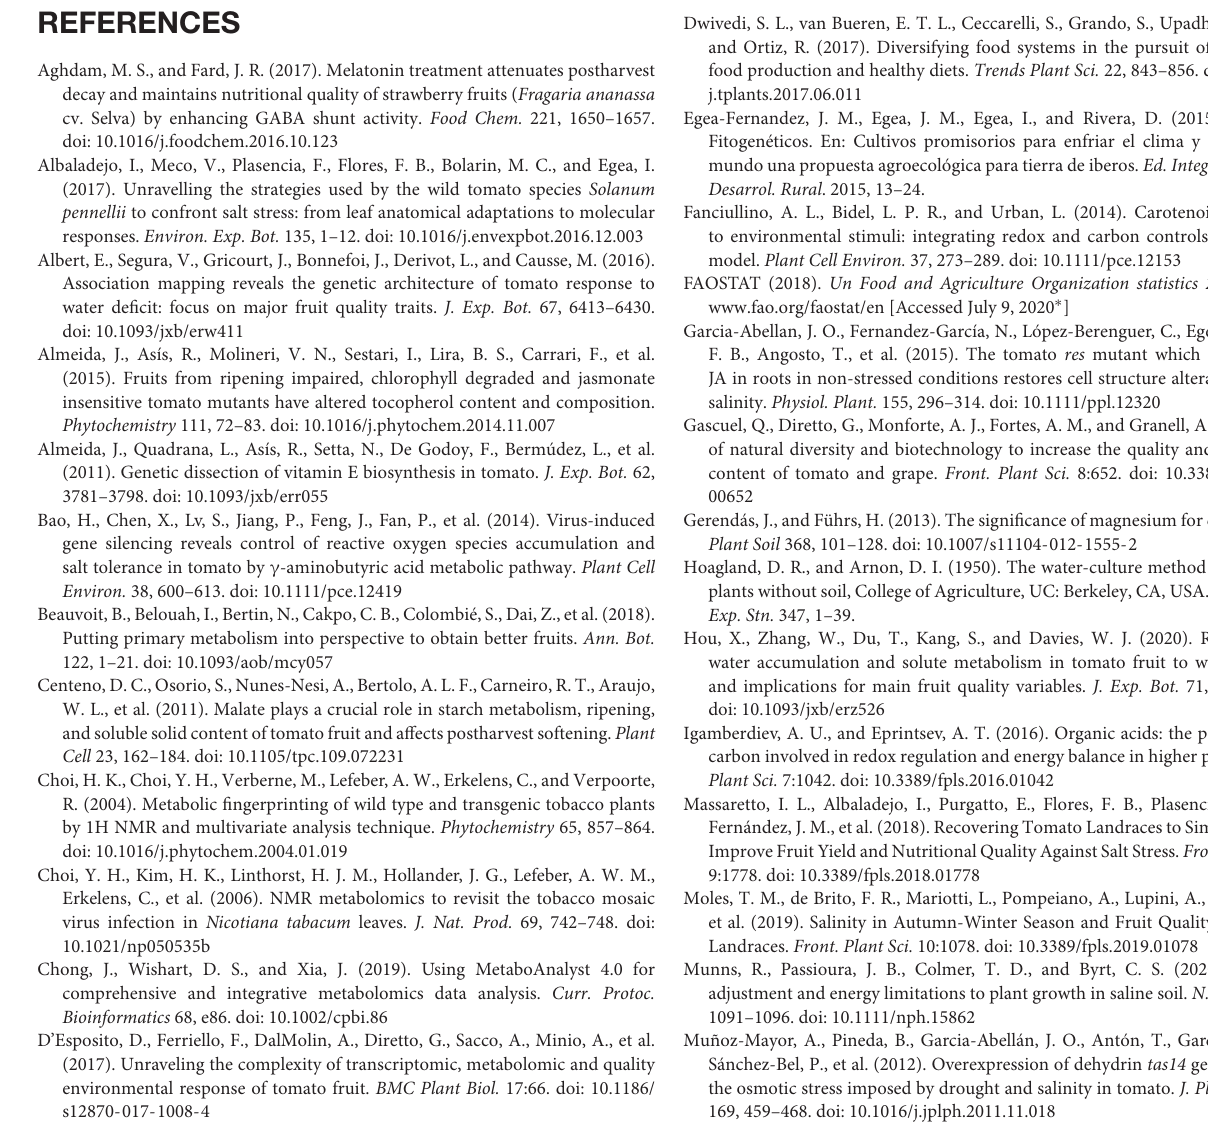
Supplementary Figure 1 | Phenotypes of “Moneymaker” (MM) and both traditional plant varieties, “Tomate Pimiento” (TP) and “Muchamiel Aperado” (MA), just before salt treatment (50 mM NaCl), after 45 days from sowing. (A) Representative images of plants and (B) traits of plant development (plant height